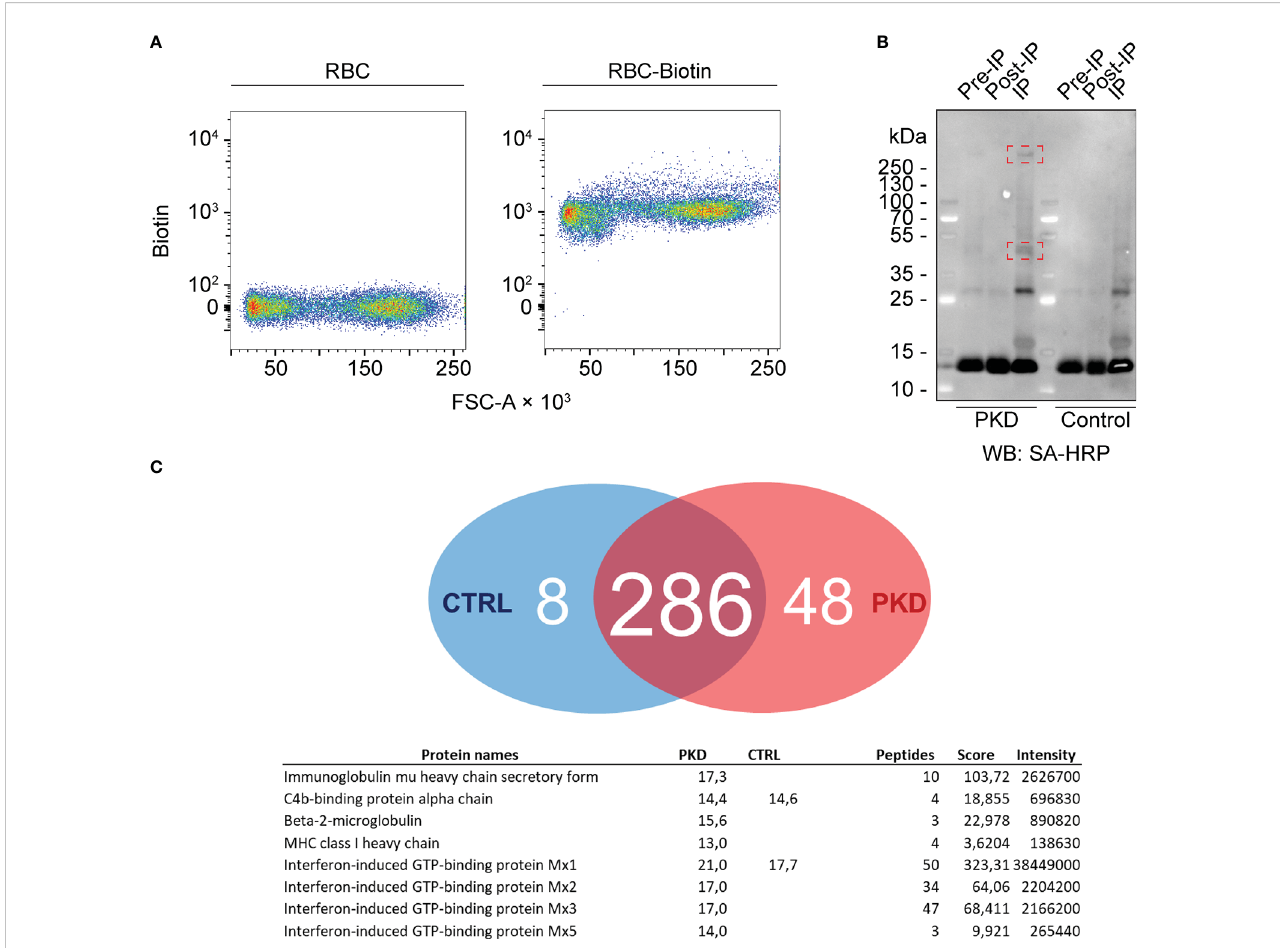
FIGURE 4 The cell surface proteome of red blood cells (RBCs) – differential surface proteins between RBCs from fi sh with proliferative kidney disorder (PKD) and control RBCs. (A) RBCs of fi sh with PKD or speci fi c pathogen-free (control) fi sh were surface-biotinylated. Biotinylation was con fi rmed by comparing non-biotinylated RBCs and biotinylated cells (RBC-Biotin). The high af fi nity of biotin for avidin allowed us to detect biotin with streptavidin (a tetramer consisting of four molecules of avidin) conjugated to PE-Cy7. The PE-Cy7 tandem dye was detected in the infrared channel and its fl uorescence measured by fl ow cytometry. Therefore, intensity of PE-Cy7 fl uorescence is proportional to the levels of biotin and is represented on the y-axis (labeled “ Biotin ” ) whereas the x-axis represents the forward scatter of these cells (FSC-A). (B) We determined any differences in cell surface proteins by lysing the cells. Again, we leveraged the af fi nity of avidin for biotin for immunoprecipitation (IP) of biotinylated proteins using ExtrAvidin-agarose resin, and western blotting (WB) with streptavidin-horse radish peroxidase (SA-HRP) (see “ IP ” lanes). Highlighted within red rectangles are one protein over 250 kDa and another approximately 48 kDa that are more abundant on the surfaces of RBCs from a fi sh with PKD. Comparing the signals from “ Pre-IP ” and “ Post-IP ” lanes faintly show depletion of these two proteins from the total lysate of IgM + RBCs before IP ( “ Pre-IP ” ). (C) Several host proteins were differentially identi fi ed between PKD (48 exclusive proteins) and control (8 exclusive proteins) groups. Most prominently, the IgM heavy chain was identi fi ed exclusively from PKD RBCs. Surprisingly, an MHC class I orthologue and associated b 2 microglobulin were also part of this group while results suggest that trout RBCs were responding to interferon during